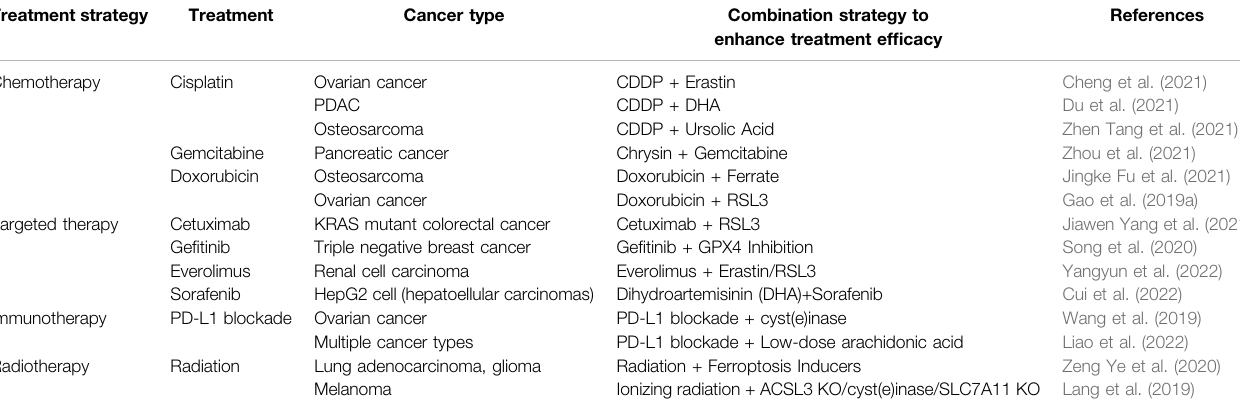
TABLE 2 | Strategy to enhance therapeutic ef fi cacy of approved treatment through regulating ferroptosis in cancer. Treatment